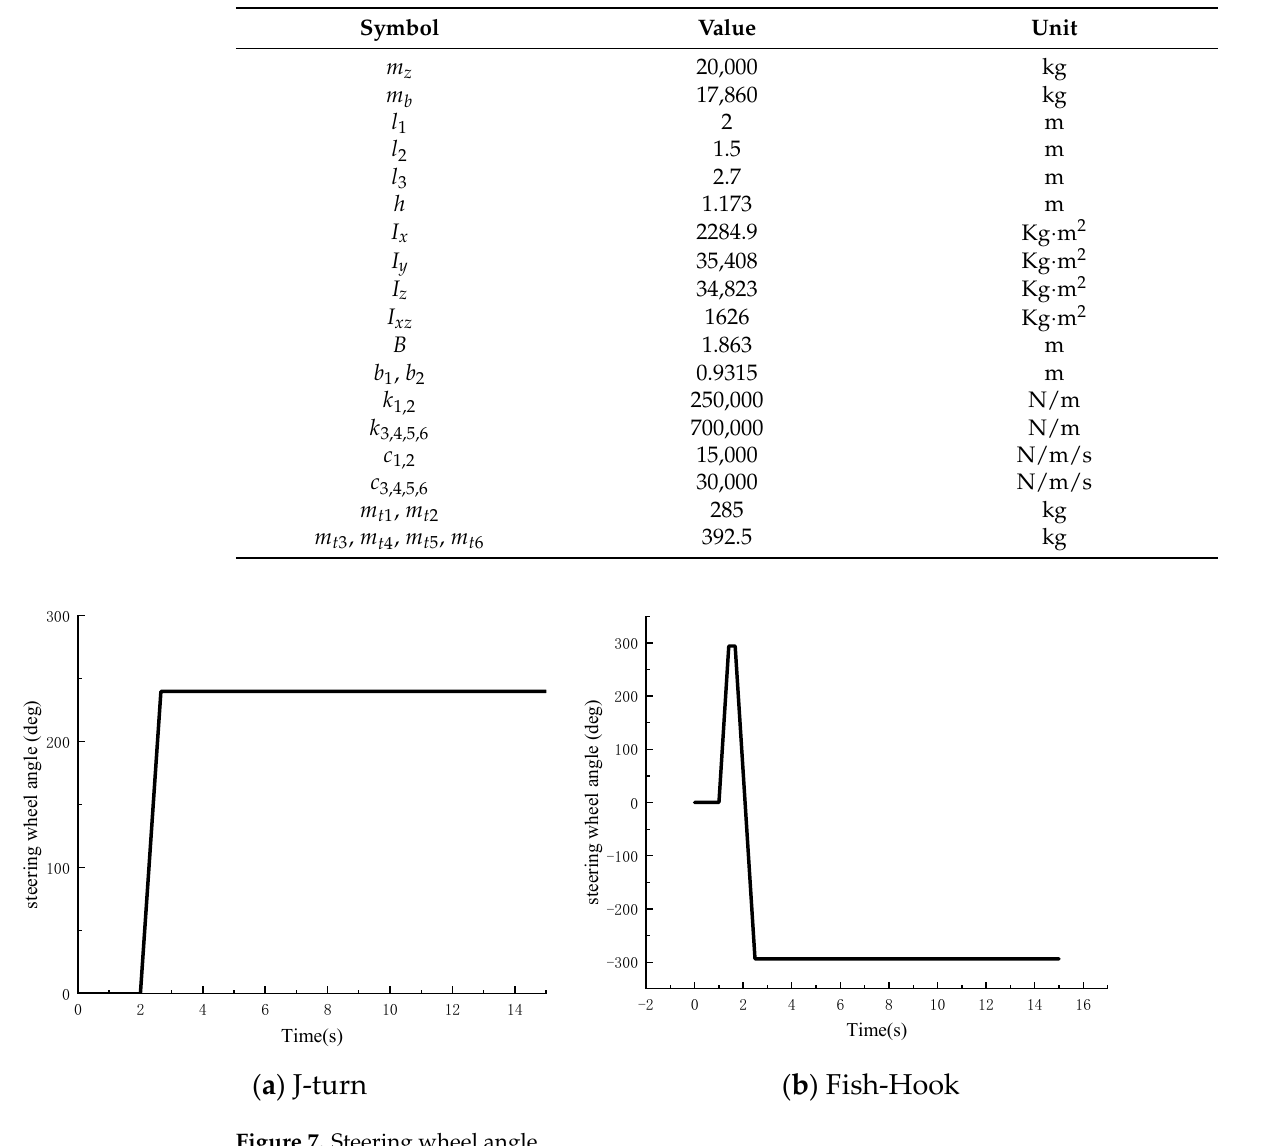
Table 2. Simulation parameters.